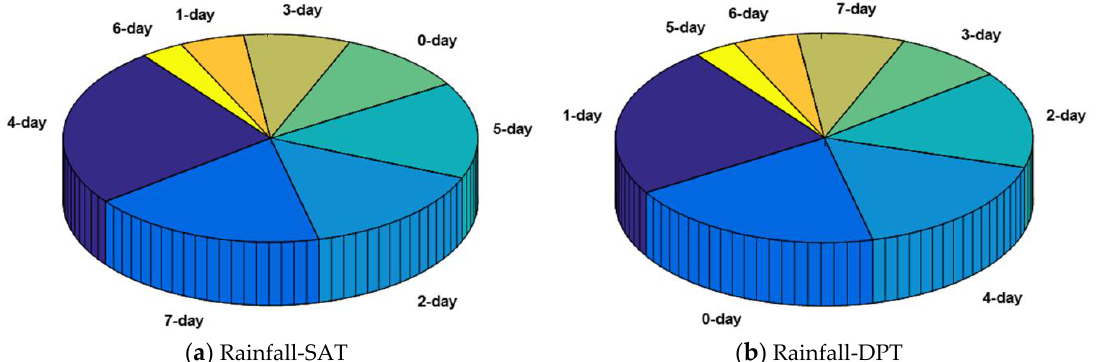
Figure 8. Distribution of preceding-day showing maximum sensitivity in annual exceedance daily rainfall depth.